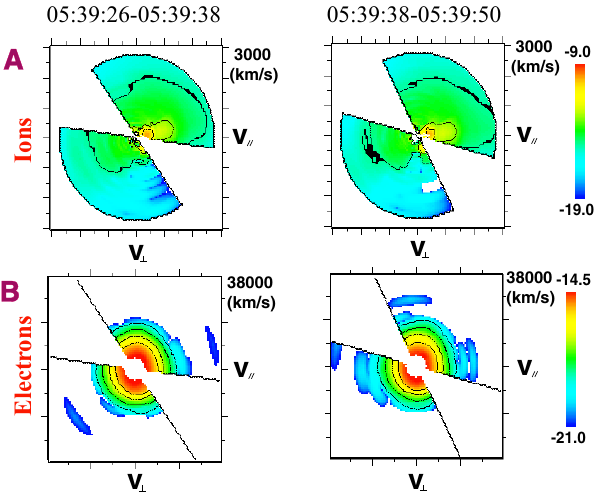
Plate 1. Distribution functions of ions (Panel A) and electrons (Panel B) for the case of the acceleration of multiple-beams per- pendicular to the magnetic field. The distribution functions are the slices of the 3-dimensional distribution functions in the velocity plane including the magnetic field B ( V k ) and the E × B drift vec- tor ( V ⊥ ). The phase space densities are color-coded according to the color bar at the right-hand side.